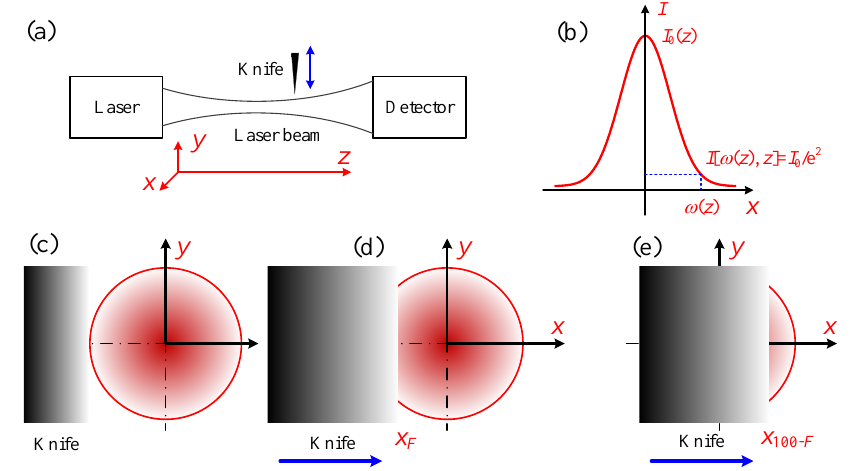
Figure 9. Principle of knife-edge method. ( a ) Schematic of measuring laser intensity distribution using knife-edge method; ( b ) definition of laser radius; ( c ), ( d ), and ( e ) procedure of knife-edge method.